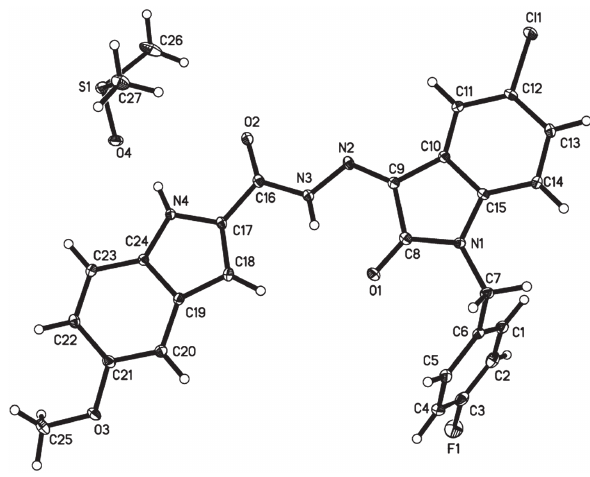
The crystal structure is shown in the figure. Tables 1 and 2 contain details of the measurement method and a list of